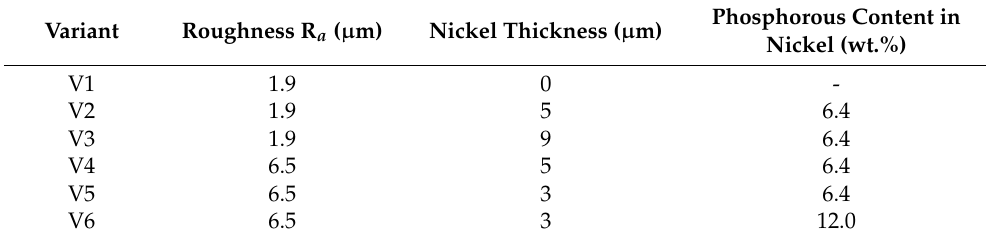
Figure 2. ( a ) Laser structured area of LCP, exhibiting a distinct sponge-like surface; ( b ) Surface after laser structuring with different laser power and cleaning processes and after metallization with Cu/Ni/Au; ( c ) Correlation of roughness and adhesive strength of the resulting metallization. The inset displays the possibility of wire bonding for the metallization with the lowest roughness. Table 1. Structural and compositional features of conductor tracks for lifetime tests obtained from different laser * and metallization ** parameters.